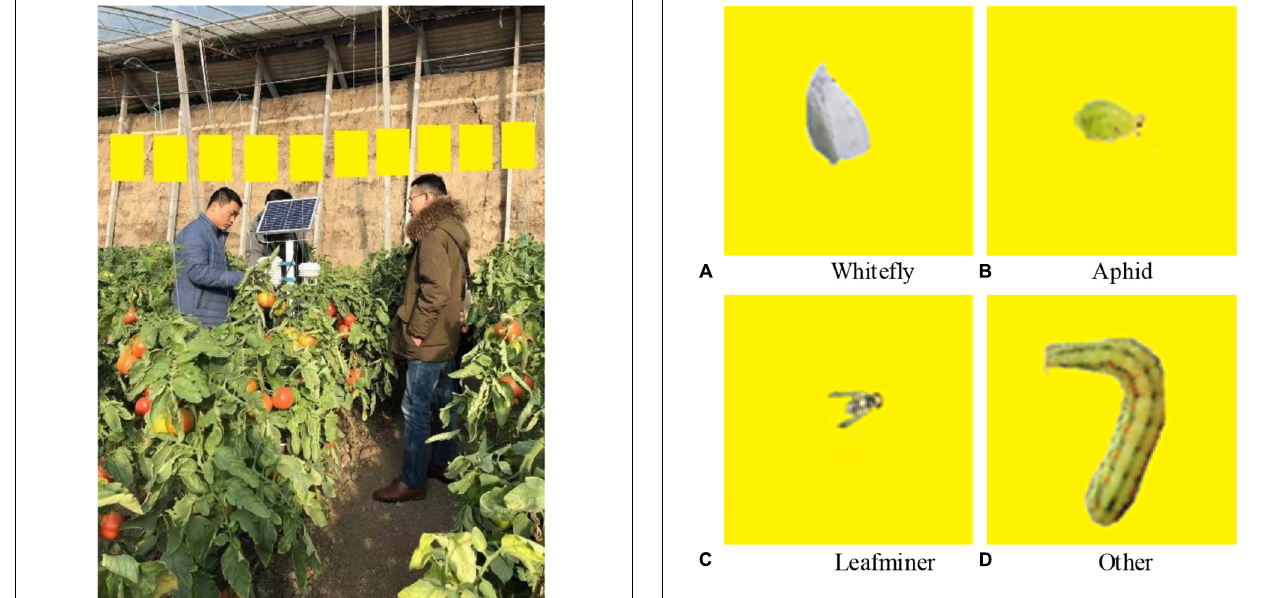
FIGURE 5 | Examples of input images used in this